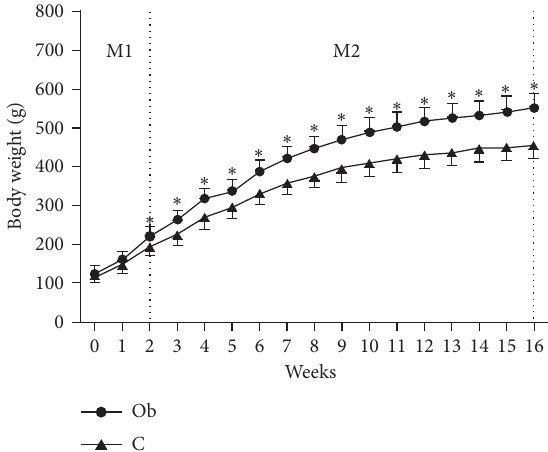
Figure 2: Evaluation of body weight during 16 weeks of experi- mental protocol. Data expressed as mean ± standard deviation.